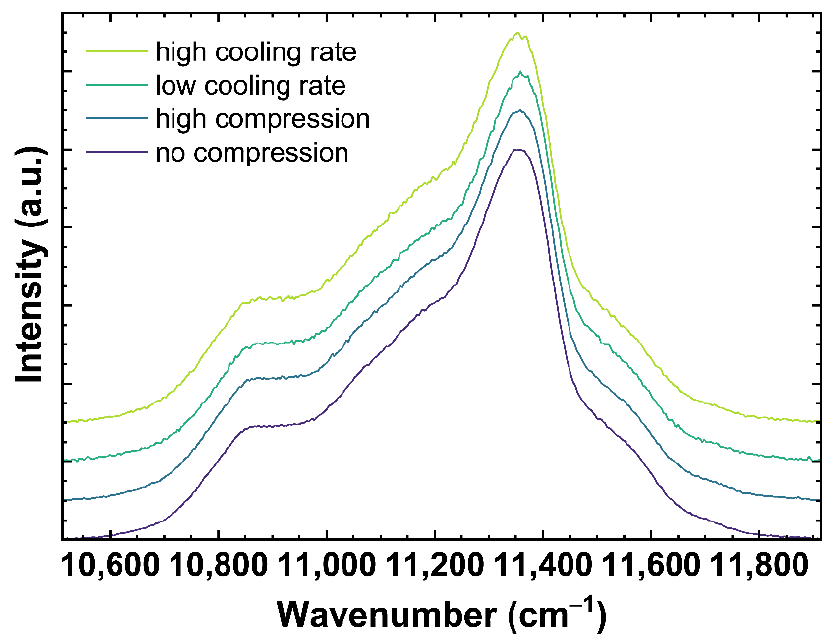
Figure 4. Neodymium 3+ luminescence spectra of OptiWhite excited at 780.42 nm. The displayed spectra show q g 1 cooled with 6 × 10 − 4 K/min (low cooling rate) and 650 K/min (high cooling rate) as well as US_T g 1 under no uniaxial compression (0 GPa) and high uniaxial compression ( − 0.85 GPa). To evaluate the observed shift of the Nd 3+ bands the σ -parameter ( σ Nd ) was calculated as described in Section 2.4.1 (see Equation (3)). The collected spectra were corrected with a linear baseline anchored to 10,513 and 11,913 cm − 1 and normalized to the total area. The σ Nd was integrated in the range from 10,513 to 11,913 cm − 1 (see α 1 and α 2 in Equation